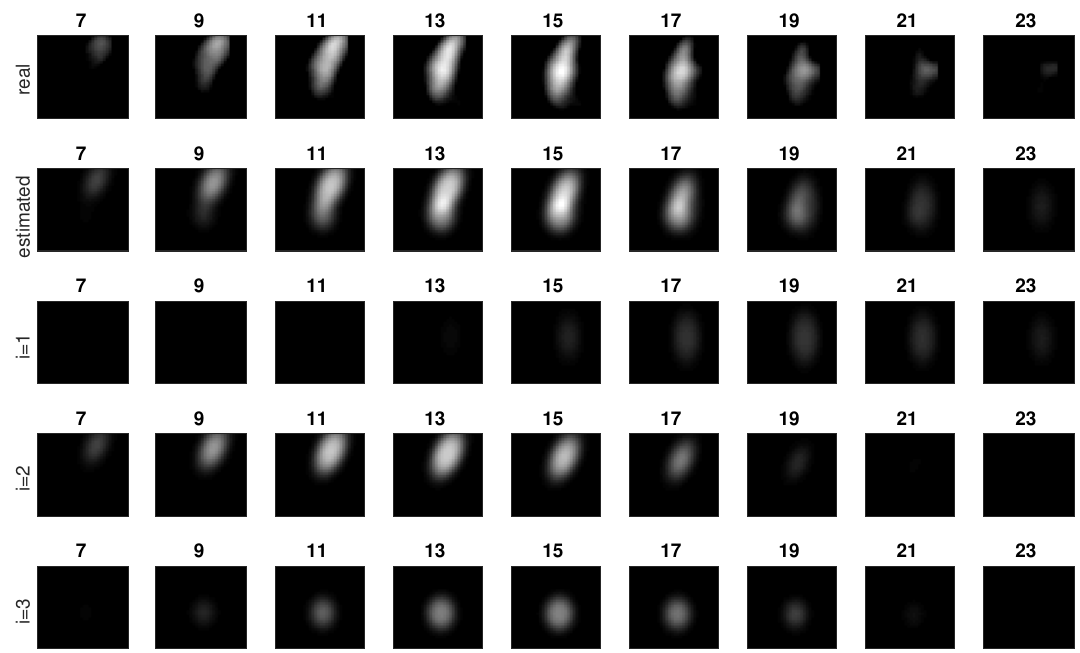
Figure 3. Exemplary slices for a real SPECT measurement with parathyroid glands (top) and estimated volume for the proposed method (three bottom rows show components of estimated volume).